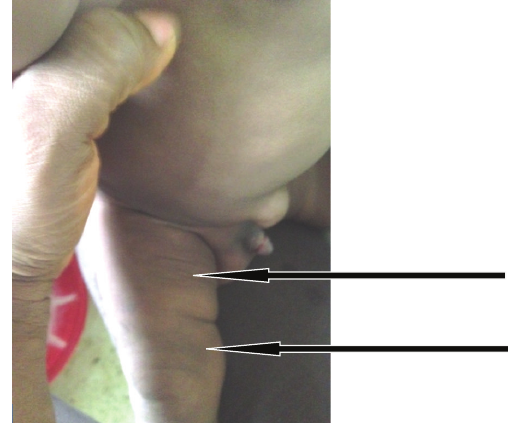
Figure 2: Subcutaneous erythematous nodules at nape of the neck noted in first week of life.